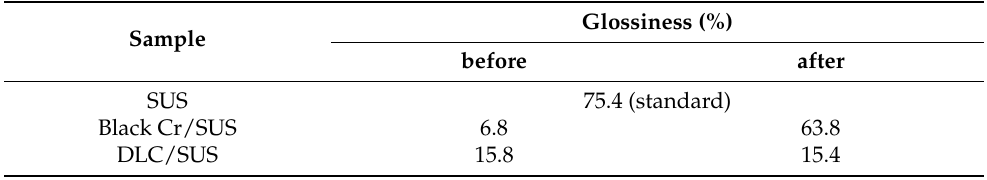
Table 5. Glossiness of samples before and after the cleaning